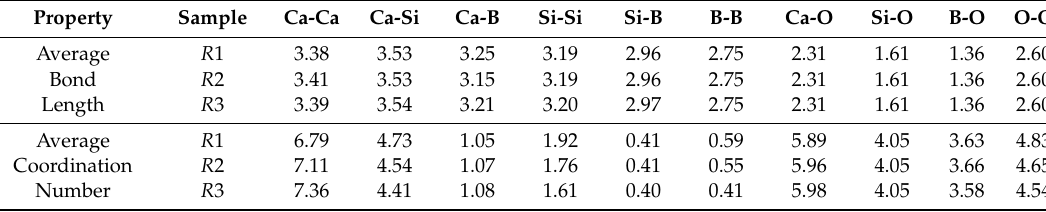
Figure 1. ( a ) RDFs and ( b ) CNs of different atomic pairs in sample R 2. Table 4. Average bond length and average coordination numbers of atomic pairs in CaO-SiO 2 -B 2 O 3 system.